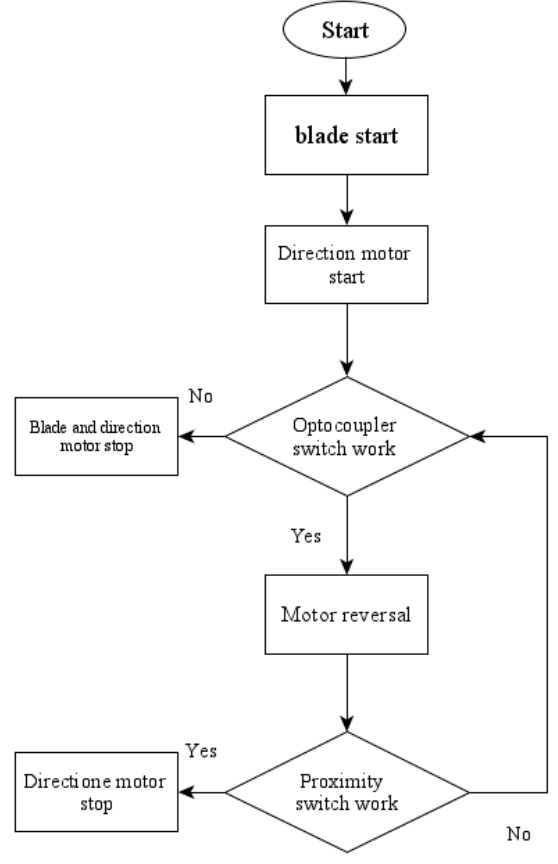
Figure 11. Control process of the mowing system.